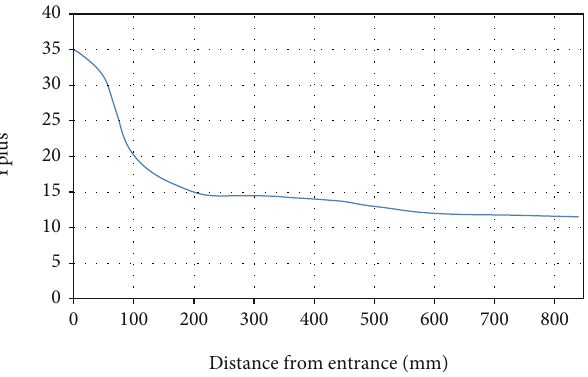
Figure 4: The trend of the wall Yplus along the axial